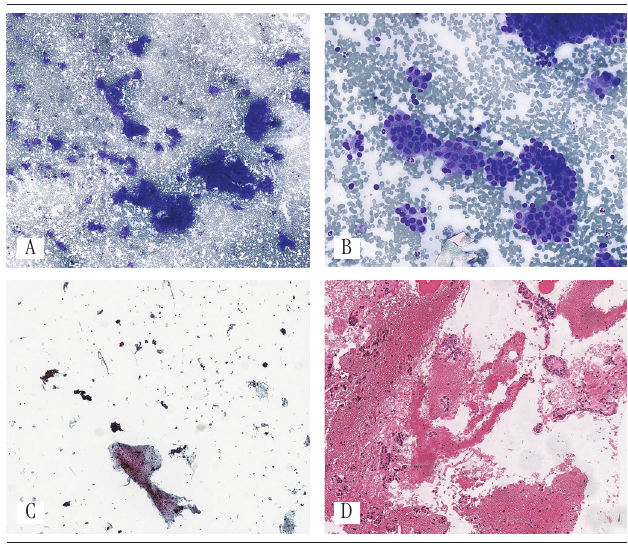
figurE 2 − An illustrative case showing most habitual cellularity in different preparations A) FNAB of thyroid nodule with final diagnosis of papillary carcinoma, with moderate/ rich (3+/4+) cellularity in CS, presenting papillary arrangement at low magnification (Panótico Rápido LB © , 4×); B) detail revealing nuclear characteristics, with presence of nuclear pseudoinclusion and irregular nuclear membrane (Panótico Rápido LB © , 20×); C) LBP demonstrating moderate cellularity and papillary arrangement (Papanicolaou, 4×); D) CB containing small papillae, with clear nuclei (HE, 20×). FNAB: fine-needle aspiration biopsy; CS: conventional smear; LBP: liquid-base preparations; CB: cell block; HE: hematoxylin and